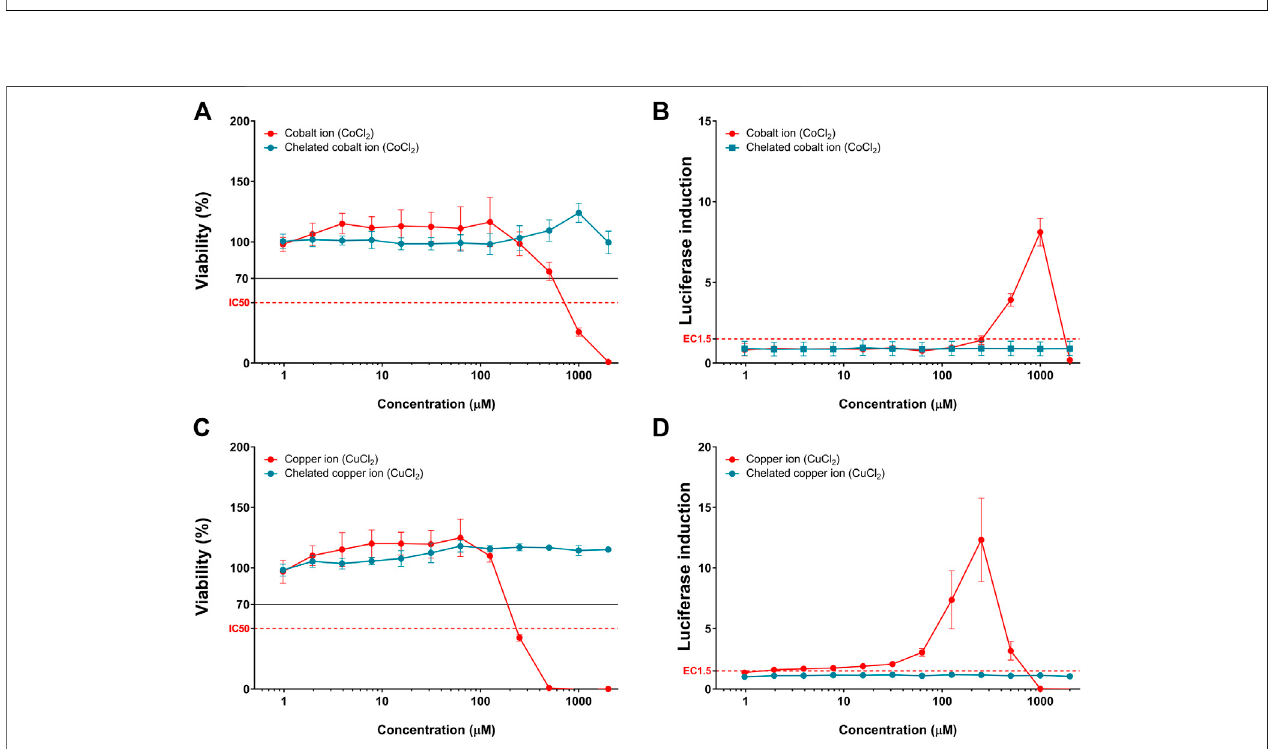
Frontiers in Pharmacology |